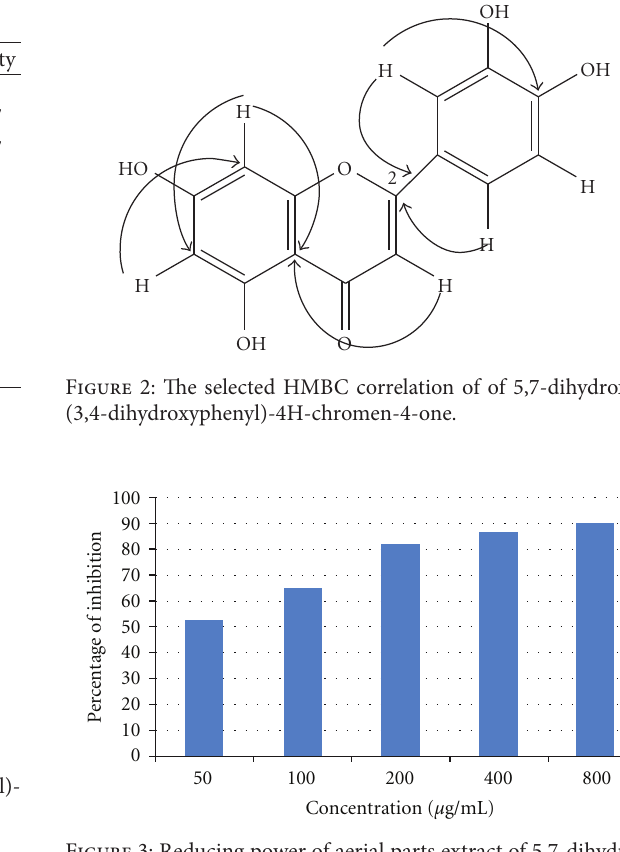
F 3: Reducing power of aerial parts extract of 5,7-dihydroxy-